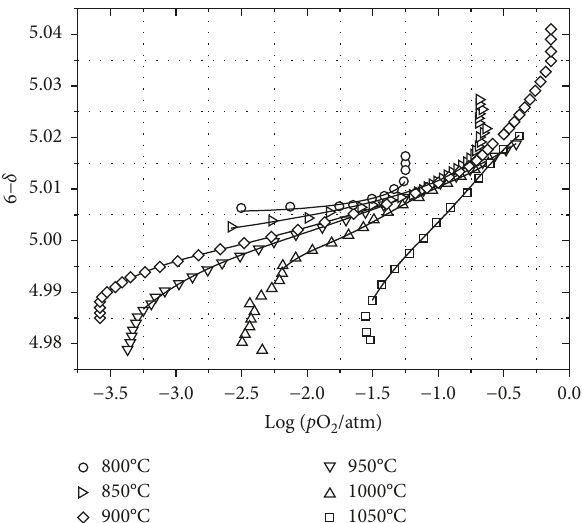
δ versus p O 2 at − − δ de- −